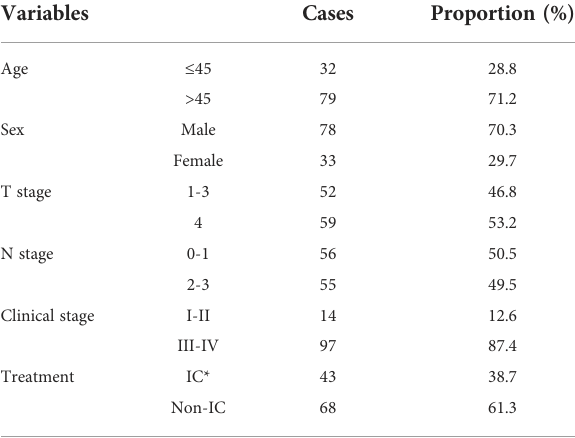
TABLE 1 Clinical characteristics of